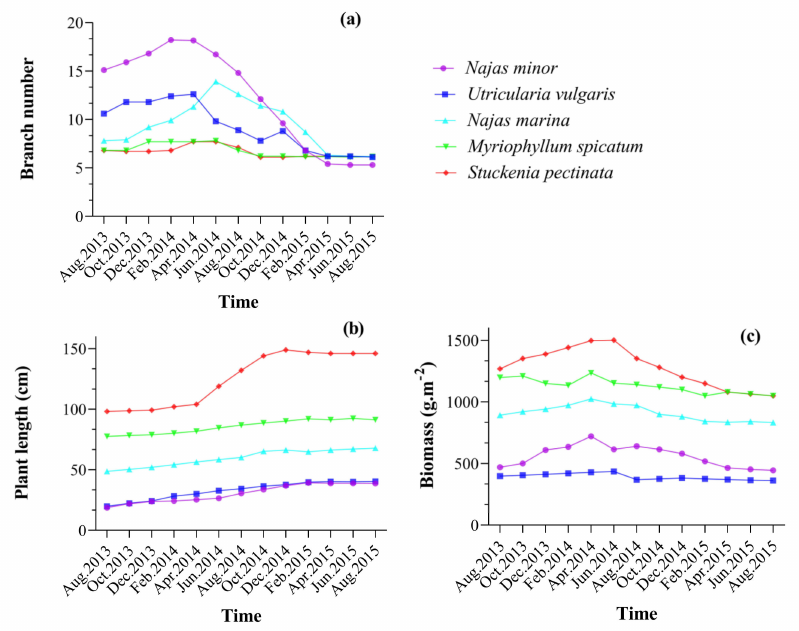
Figure 4. The influence of water level fluctuation on the growth characteristics of submerged macrophytes: ( a ) branch number; ( b ) plant length; ( c ) biomass (low water level before June 2014 and high water level after June